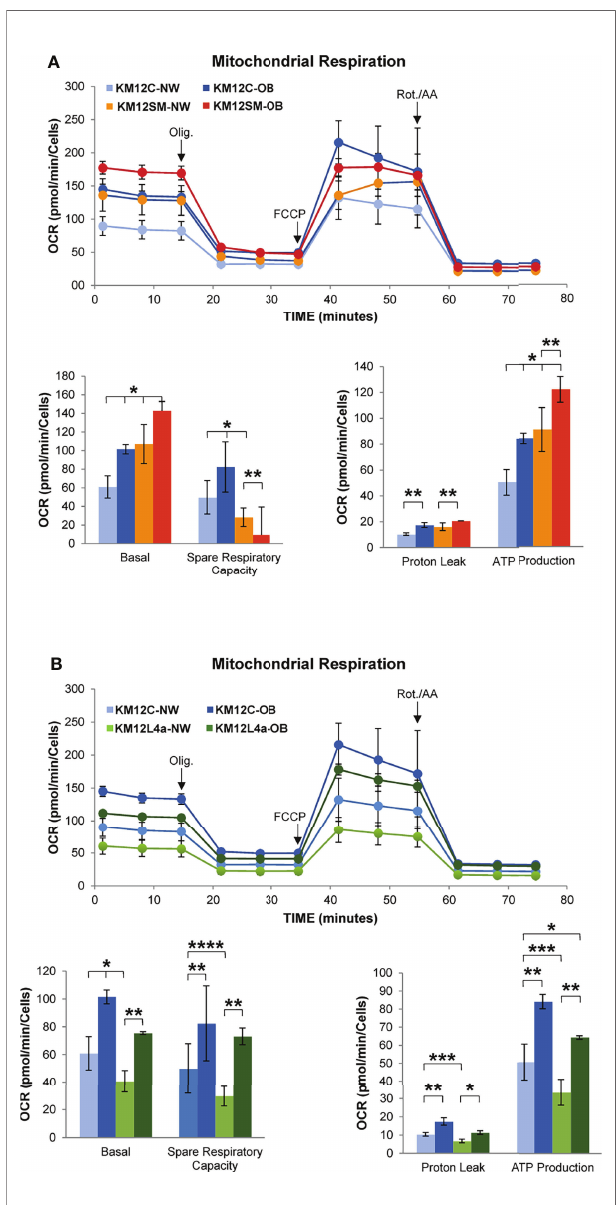
FIGURE 7 | Investigation by fl ux analysis of mitochondrial respiration of KM12 cells incubated with plasma from volunteers. (A) Analysis of mitochondrial respiration of KM12C and KM12SM cells incubated with 5% plasma of volunteers with BMI <25 (NW) or BMI >30 (OB). Basal OCR and spare respiratory capacity, proton leak, and ATP production are shown. (B) Analysis of mitochondrial respiration of KM12C and KM12L4a cells incubated with 5% plasma of volunteers with BMI <25 (NP) or BMI >30 (OB). Basal OCR and spare respiratory capacity, proton leak, and ATP production are shown. Olig, oligomycin; Rot./AA, rotenone/antimycin (A) * p value < 0.05; ** p value < 0.01; *** p value < 0.001; **** p value <